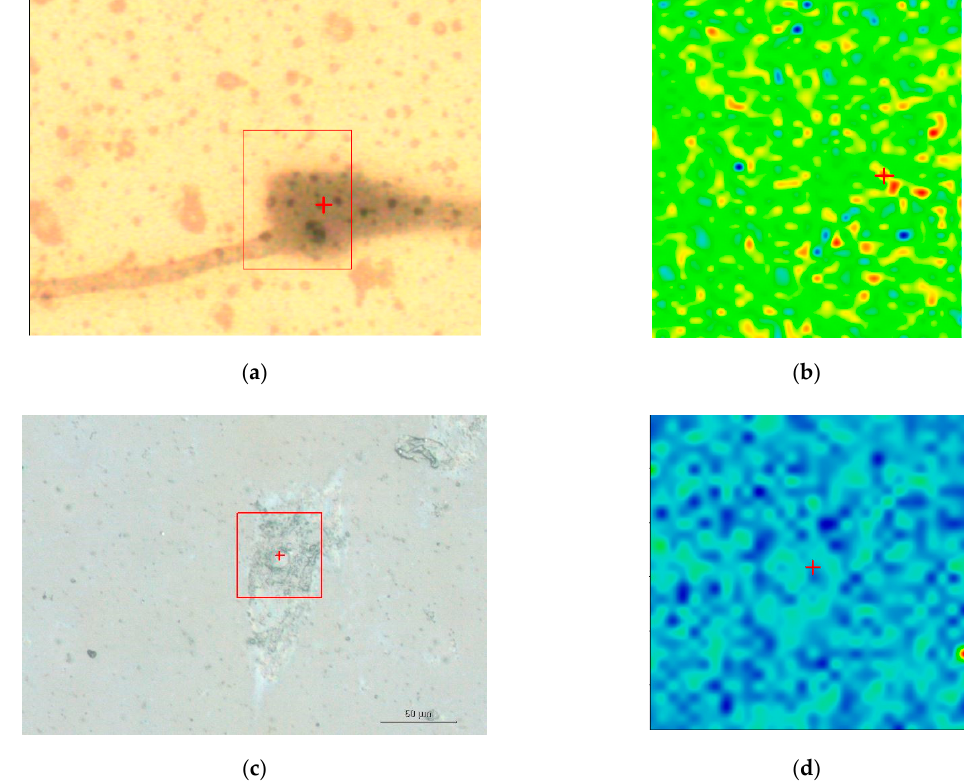
Figure 4. Raman chemical maps of a MG-63 cell and an osteo-differentiated MSC. The images a and c represent the cell morphologies with the red box denoting the area under Raman investigation for MG-63 ( a ) and osteo-differentiated MSC ( c ), respectively. The images A (area 30 × 40 μ m 2 ) and C (scale bar 50 μ m) were recorded making use of 50 × magnification. The images B and D represent the chemical Raman imaging for the MG-63 ( b ) and the osteo-differentiated MSC ( d ), respectively, reporting the correspondent distribution of HA (960cm − 1 ). Under the experimental setup adopted, the chemical Raman maps were collected with steps of nearly 1 μ m.